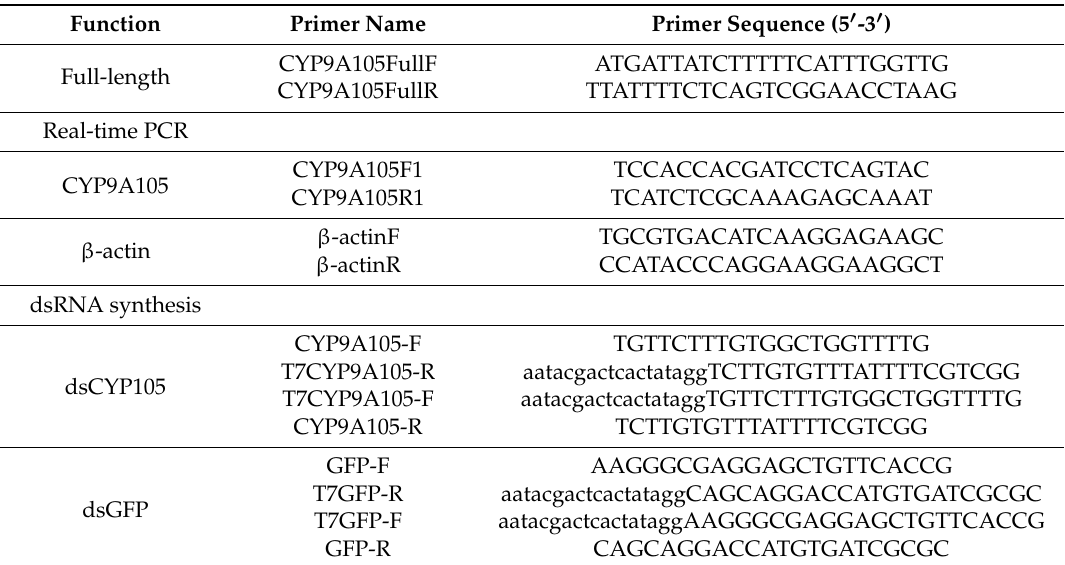
Table 2. Primers used in this